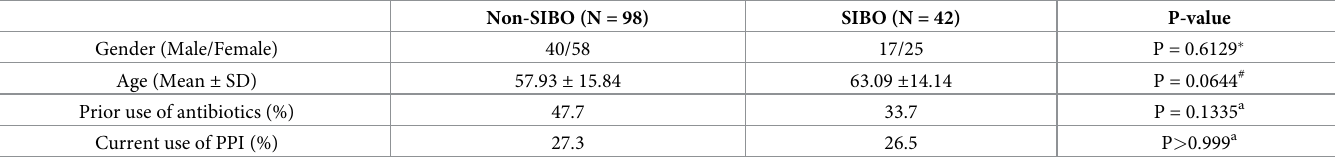
Table 1. Demographics for non-SIBO and SIBO